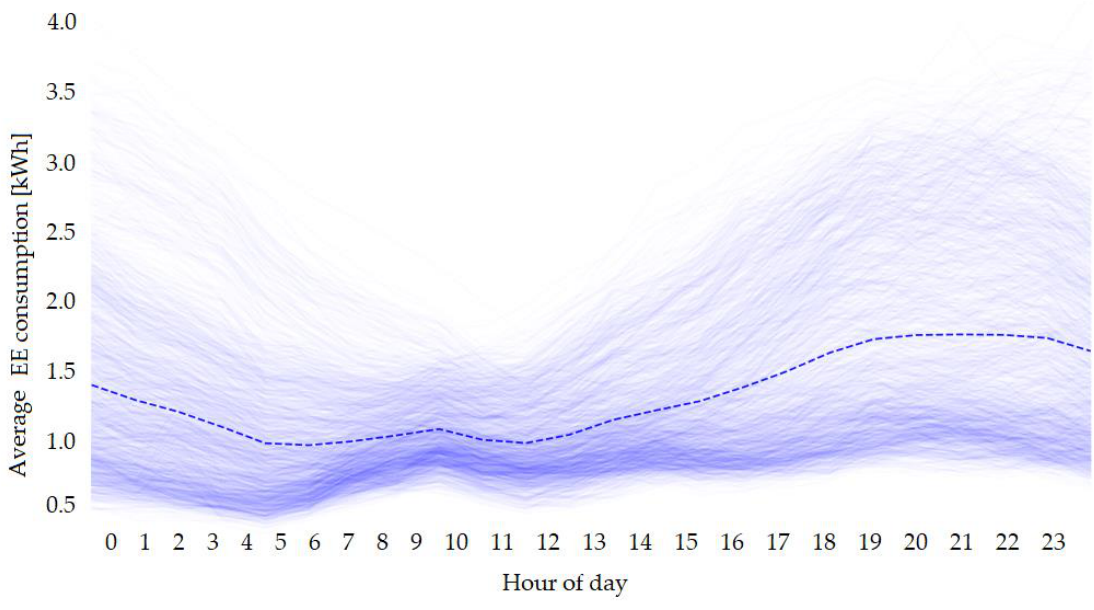
Figure 2. Average daily EE consumption.